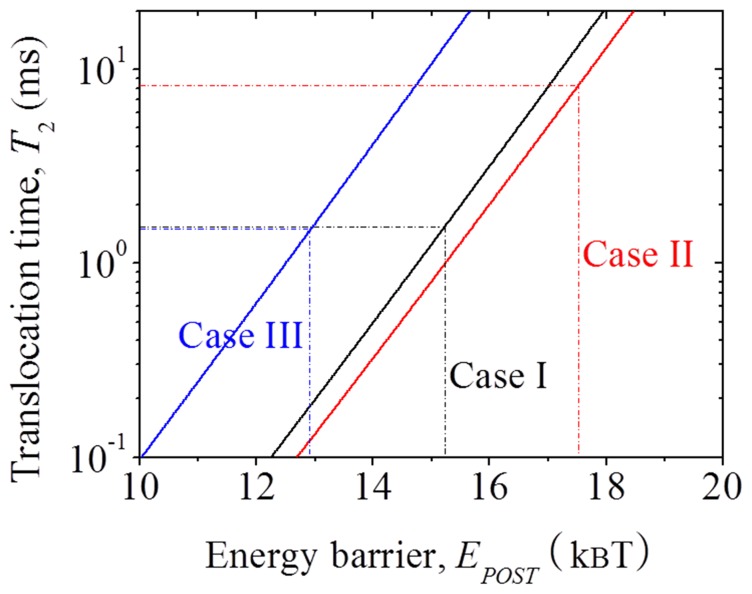
Results of forward mRNA translocation time T
2 as a function of energy barrier EPOST after the binding of EF-G.GTP, which are calculated by using Eq. (7), with ENR = 23.87kBT and EH = 24.24 kBT (black line, Case I), ENR = 23.02 kBT and EH = 26.54kBT (red line, Case II), and with ENR = 24.72kBT and EH = 21.94kBT (blue line, Case III).